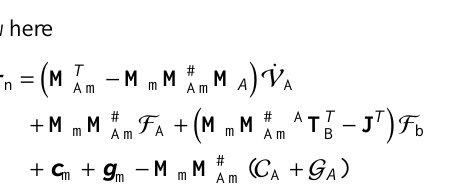
Figure 10. Snapshots from the simulation with two equivalent pla- nar 3R redundant manipulators tracking a semi-circular path and ap- plying a desired force. The blue / red arrows denote the desired mo- tion / force vectors, respectively. No null-space motion is involved. In the RNS simulation (upper graphs) no significant arm reconfig- uration is observed; in the OSF simulation (lower graphs), on the other hand, significant arm reconfiguration (spurious link motion) is observed (Hara et al.,